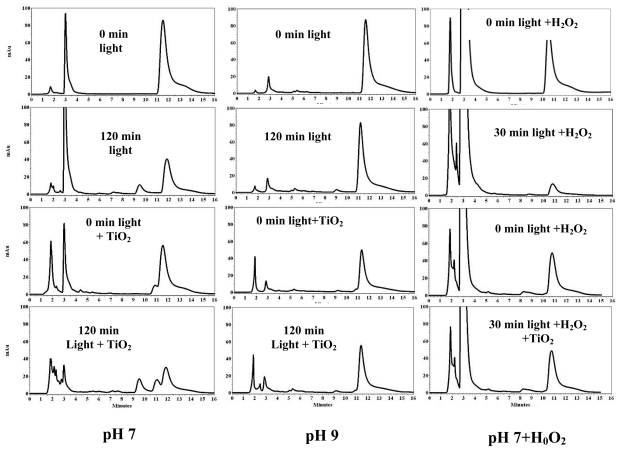
HPLC chromatogram of 3,3′,4,4′-tetrachlorobiphenyl (11.5 ± 0.2 min) irradiated at pH 7 or 9 and in the presence of H2O2 and/or TiO2.